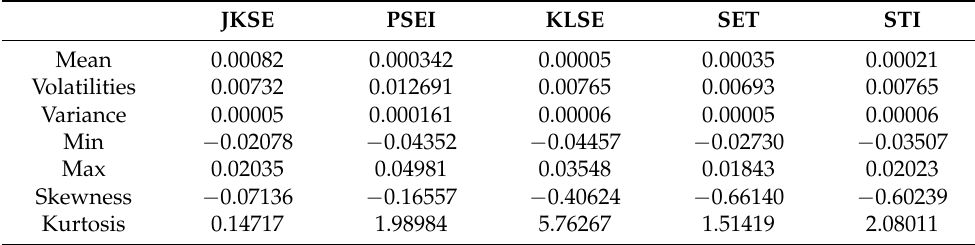
Table 3. Descriptive statistics of ASEAN top 5 stock price index